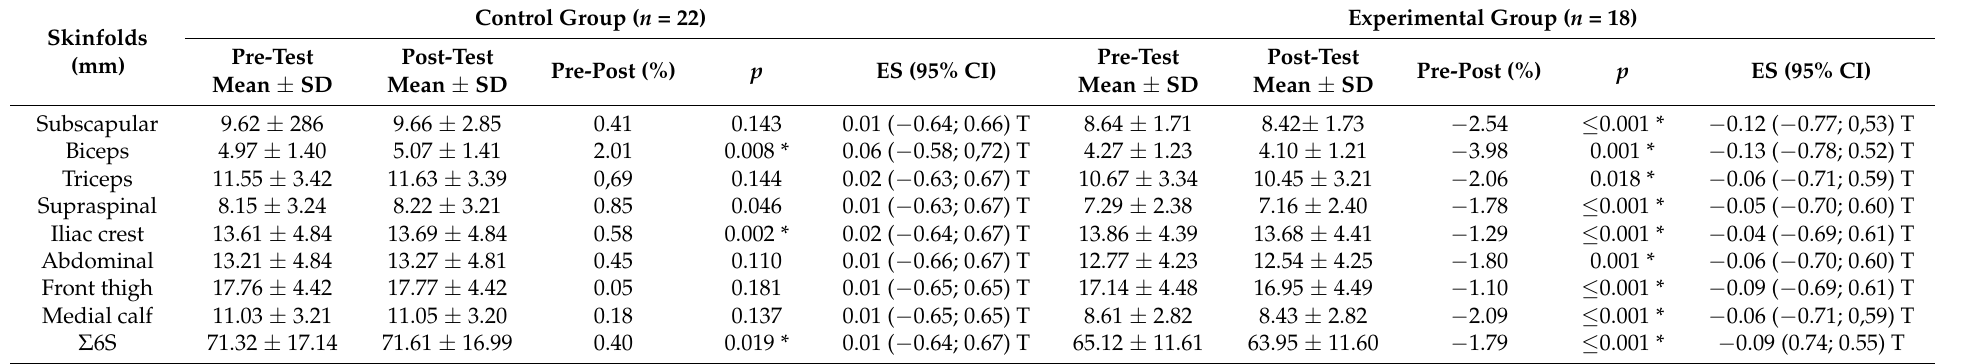
Table 4. Summary results of skinfold variables within the control group and neuromuscular training group.